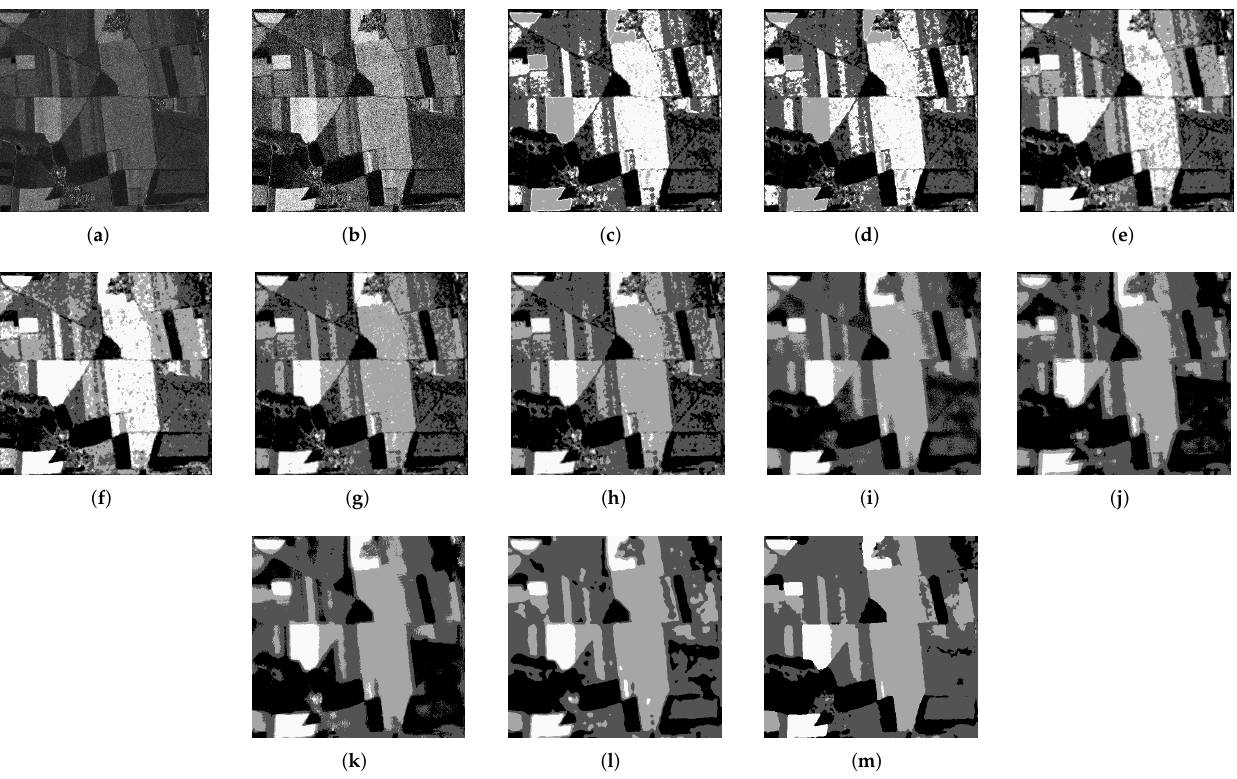
Figure 15. The segmentation results on real image 4. ( a ) Original image. ( b ) FCM. ( c ) FCM_S1. ( d ) FCM_S2. ( e ) KFCM_S1. ( f ) KFCM_S2. ( g ) EnFCM. ( h ) FGFCM. ( i ) FCM_NLS. ( j ) NS_FCM. ( k ) RFCM_BNL. ( l ) LBNL_FCM. ( m )